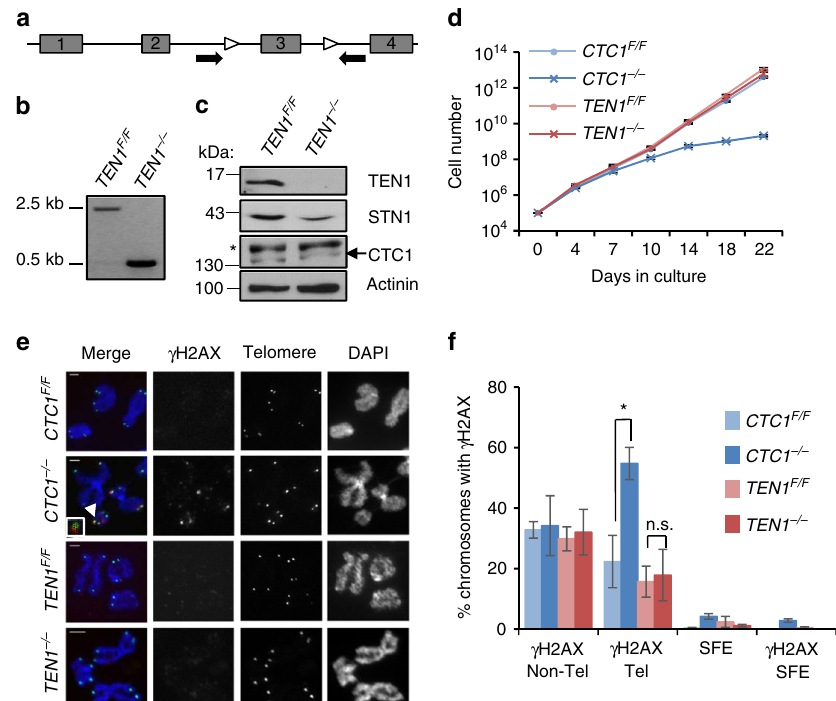
Fig. 1 TEN1 gene disruption. a Modi fi ed TEN1 gene locus. White arrowheads: loxP sites fl anking exon 3. Black arrows: PCR primers used to verify exon deletion. b PCR verifying gene disruption. TEN1 conditional cells ( TEN1 F/F cells expressing Cre-ER) were grown with ( TEN1 − / − ) or without tamoxifen ( TEN1 F/F ) for 7 days. c Western blot analysis showing levels of TEN1, STN1, and CTC1 in same cells as b . Blot was probed with antibody to TEN1, CTC1, STN1, or actinin as a loading control. *non-speci fi c band. d Representative growth curves showing proliferation after TEN1 or CTC1 disruption. e , f γ H2AX localization on metaphase chromosomes after 12 days growth with/without tamoxifen. Scale bars = 2 μ m. e Images showing γ H2AX staining. Telomeres detected by FISH (green), γ H2AX by immunostaining (red), chromosomes are counterstained with DAPI (blue). Arrow indicates FISH and γ H2AX co- localization, insert shows enlargement of same region. f Quanti fi cation of chromosomes with γ H2AX foci on chromosome arms (Non-Tel), at one or more telomeres with detectable telomeric DNA (Tel) or at signal free ends (SFE). N = 3 independent experiments, error bars indicate mean ± SEM * P < 0.05.